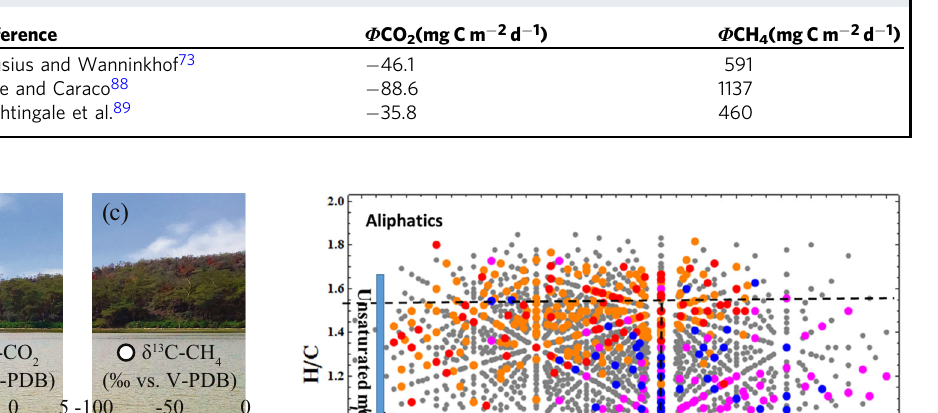
Table 1 Values of CO 2 and CH 4 fl uxes ( Φ CO 2 and Φ CH 4 ) estimated by applying published empirical relationships for the determination of k 600,i , at T = 21 °C and wind speed U 10 = 2 m s − 1 .